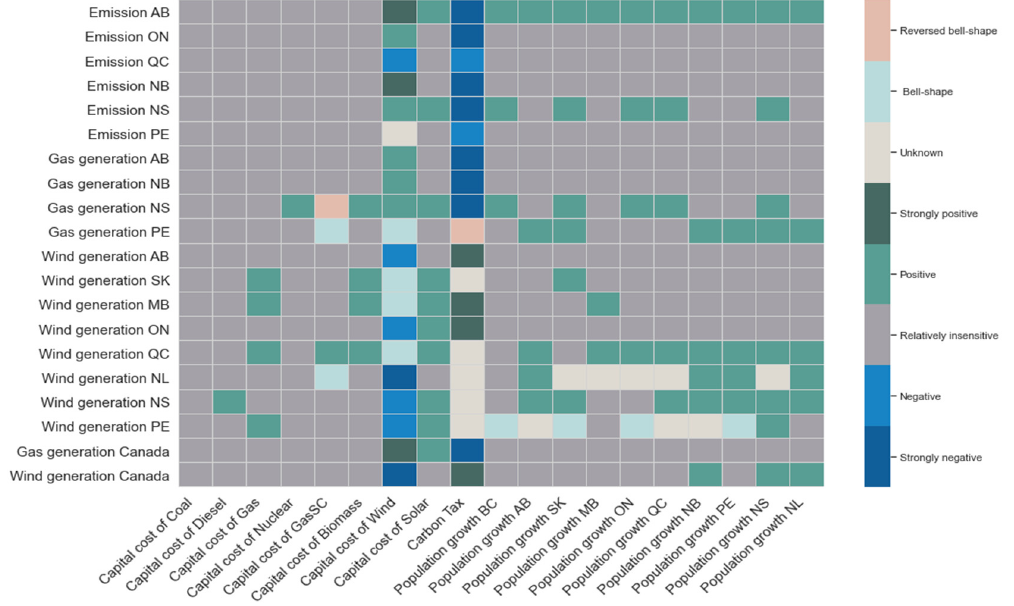
Figure 4. This heat map shows the relationship between the inputs ( x -axis) and outputs ( y -axis) in 2040. It includes only design variables that have variations in the training dataset. The correlations are color-coded based on the shape of input-output correlation plots. The plots are scaled for each output based on the minimum and maximum values, so the relationships depicted in the heat map are relative to the specific output being considered. The heat map provides a visual representation of how each input affects each output and allows for easy identification of the strongest relation- ships.